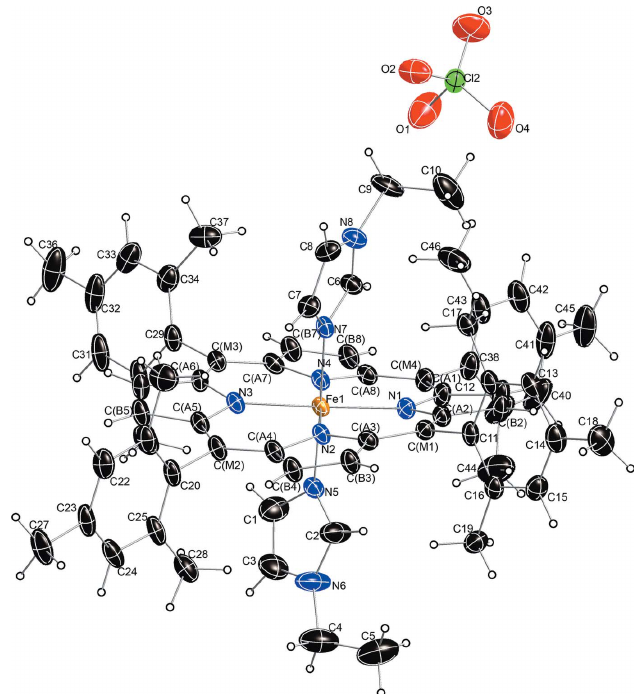
Figure 1 The molecular entities in the title compound, with displacement ellipsoids drawn at the 50% probability level. Only the major part of the disordered perchlorate anion is displayed; the chlorobenzene solvent molecules were omitted for